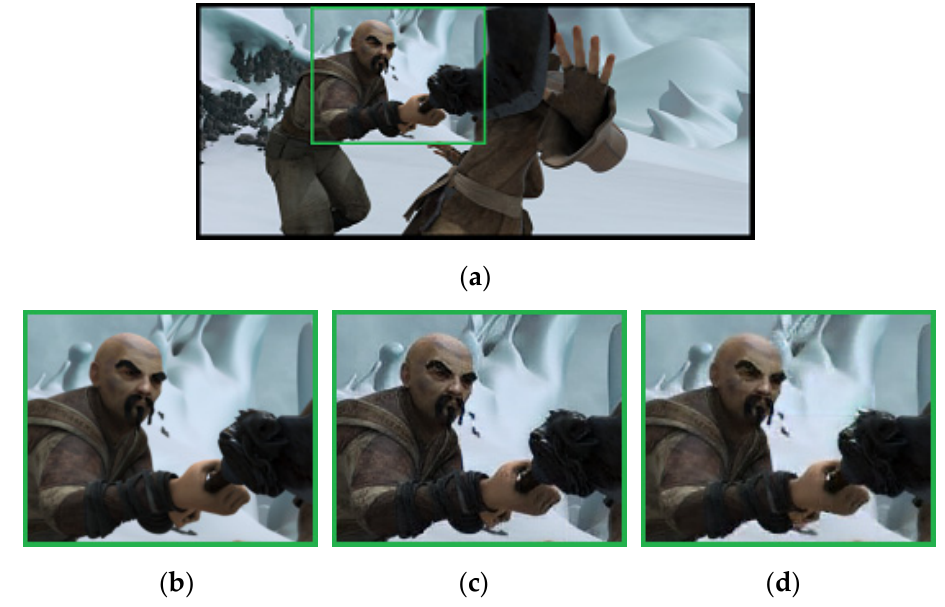
Figure 6. Experimental results on the Sintel datasets. The figures are demonstrated in two rows: ( a ) The full ground truth, ( b ) the ground truth, ( c ) the output of the proposed method without refinement (PSNR = 27.96, SSIM = 0.860), ( d ) the output of the proposed method with refinement (PSNR = 29.08, SSIM = 0.871).